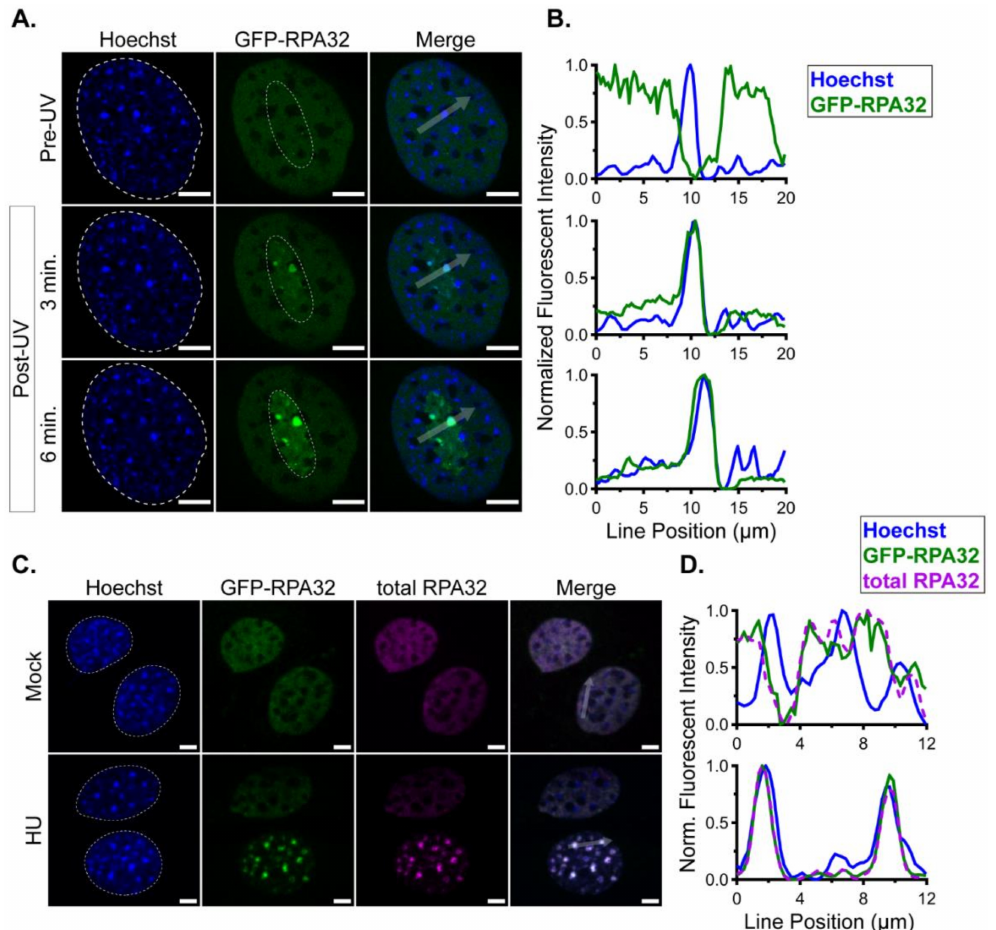
Figure 1. GFP-RPA32 relocalizes to cellular DNA damage foci. Mouse cell lines stably expressing GFP-RPA32 were imaged before and after induction of cellular DNA damage by UV irradiation (405 nm laser) or 5 mM hydroxyurea (HU). ( A ) Hoechst (blue, left column), GFP-RPA32 (green, middle